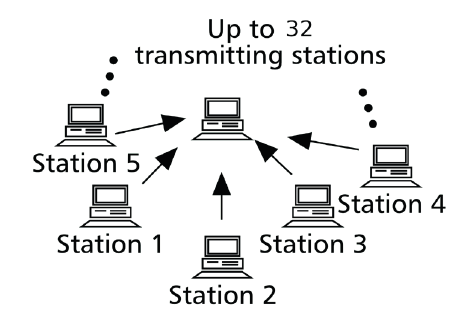
Fig. 4. Simulation topology.